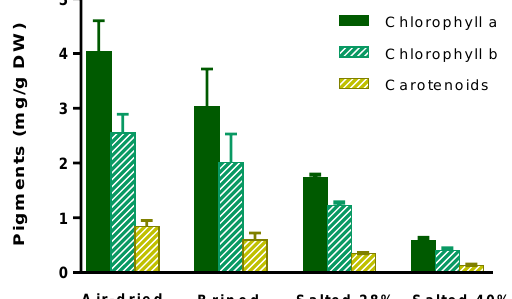
Figure 1. Levels of chlorophyll a, b and total carotenoids extracted from Ulva rigida submitted to di ff erent preservative processes (air-drying, brining, salting at 28% and 40%) after six months of storage. The macroalgae were stored at room temperature (air-dried) or at 4 °C (salt-processed). The results correspond to mean ± standard deviation (n = 3).